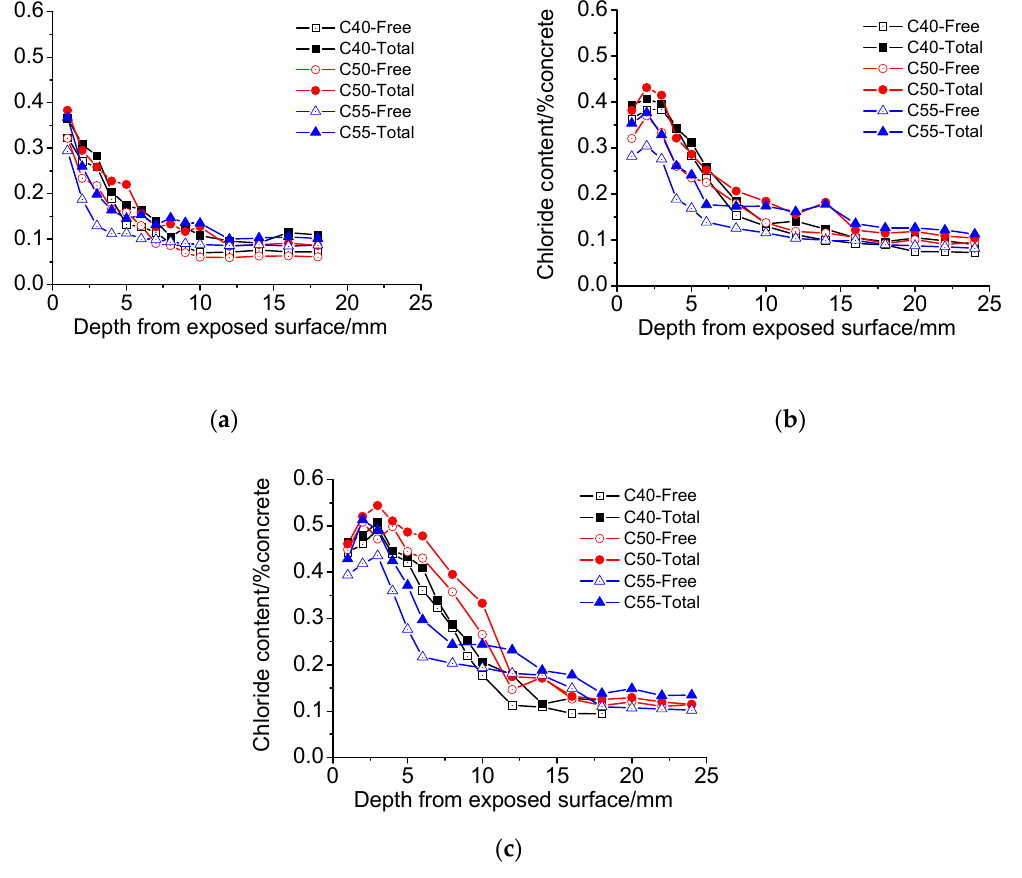
Figure 12. Chloride distribution of C40, C50, and C55 exposed to the tidal zone after different times. ( a ) 1 month. ( b ) 3 months. ( c ) 9